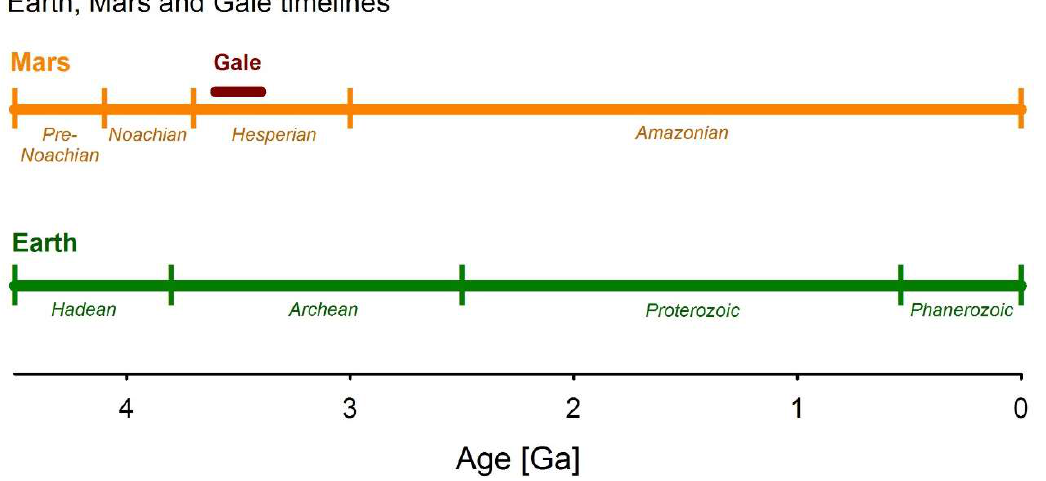
Figure 1. Timeline of the geologic eons on Earth and Mars, drawn after Carr and Head (2010) [44], see there for details of the geologic history of Mars. The red bar shows the timing and duration of the sedimentary cycle at Gale crater as given by Paulucis et al. (2016) [34].